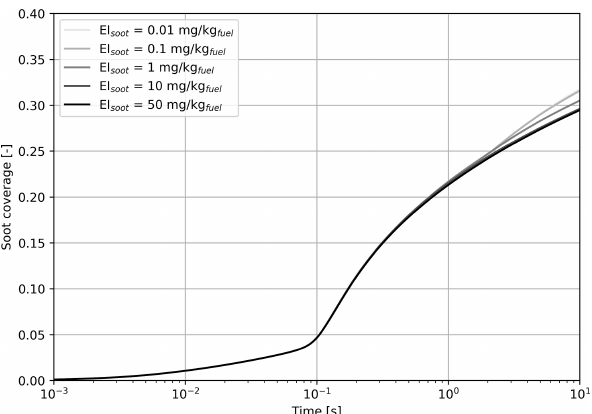
Figure 5. Simulated black carbon fraction coverage as a func- tion of the black carbon mass emission index, varied from 0.01 to 50mgkg − 1 . fuel